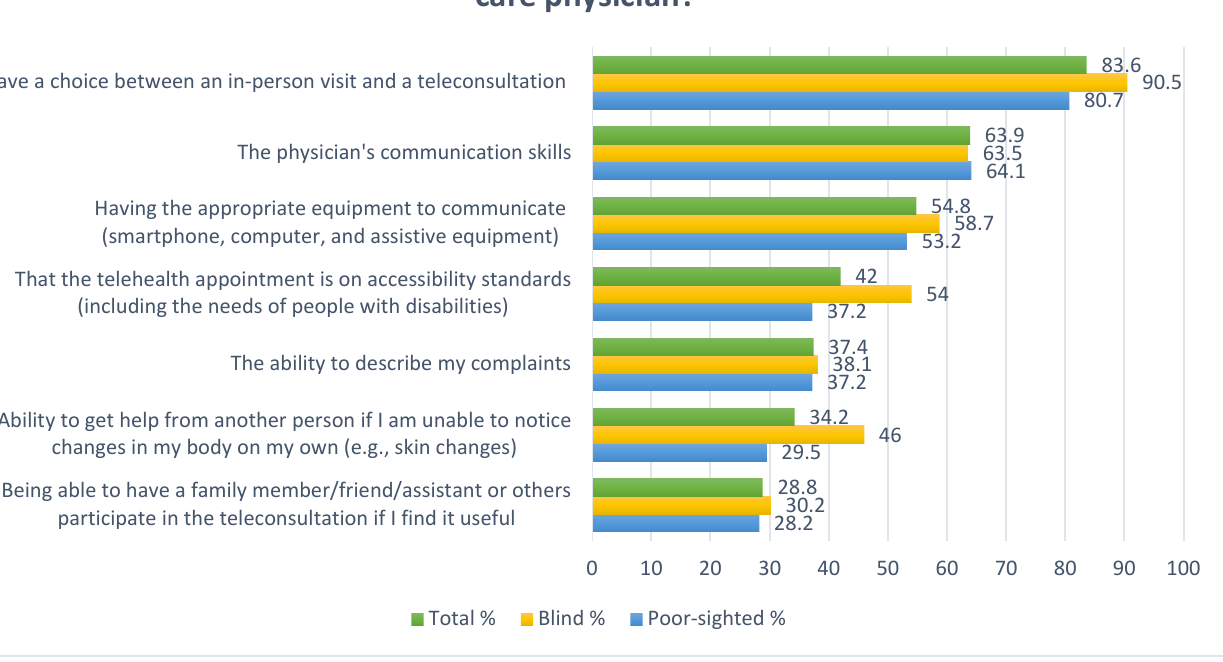
Figure 2. Needs of PVIs in the context of TCs with PCP in percentages.